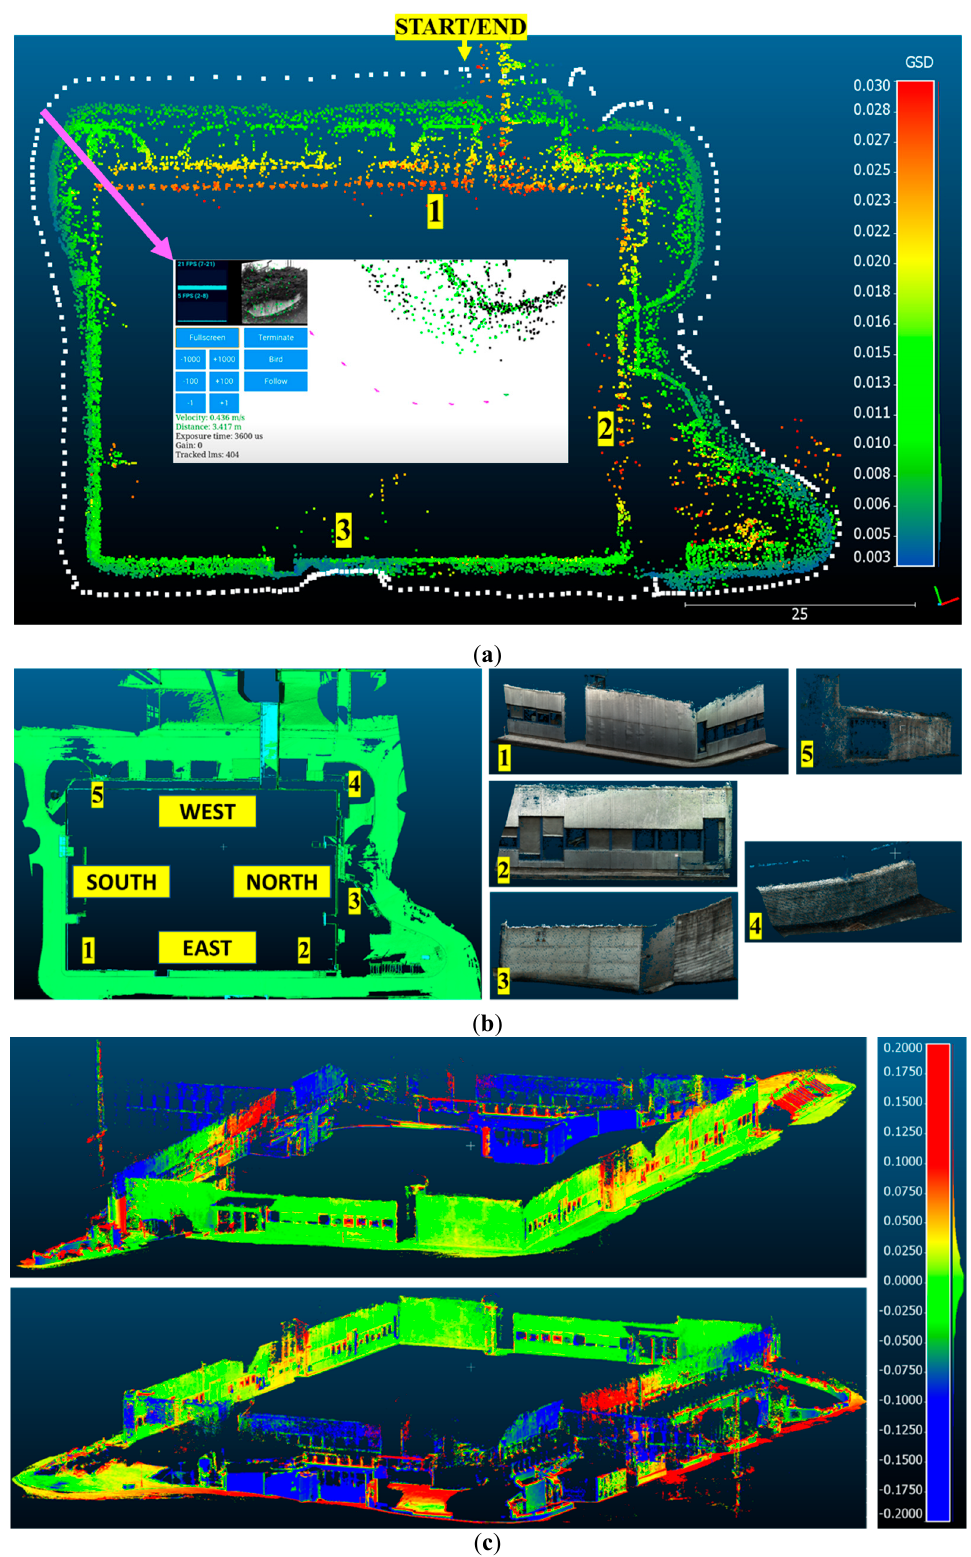
Figure 10. ( a ) Top view of the estimated camera positions of the selected images (white squares) and derived GSD-color- coded point cloud. ( b ) Building areas used to align the derived dense point cloud with the laser scanning ground truth. ( c ) Dense point cloud obtained using the poses estimated by our system (Case 1.), with color-coded signed Euclidean distances [m] with respect to the ground truth.